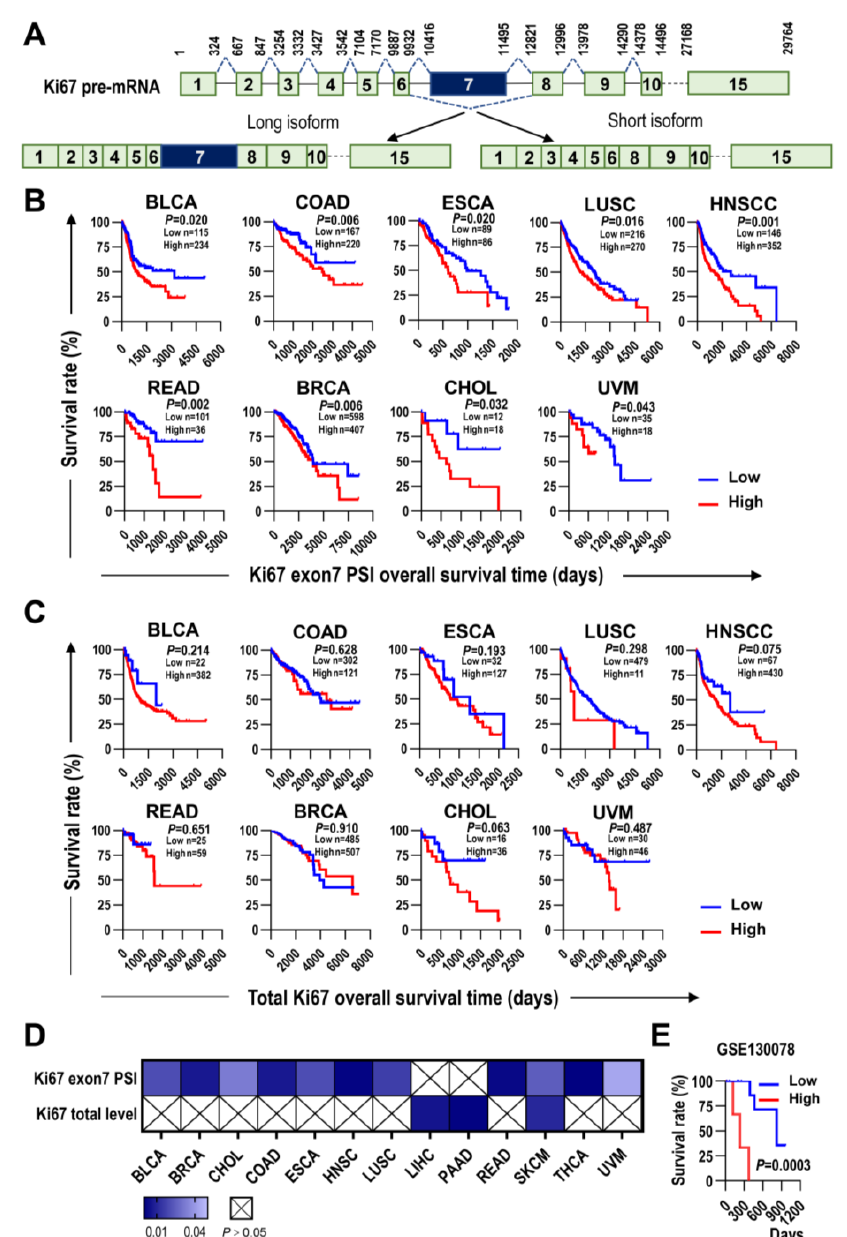
Figure 1. The inclusion level of Ki67 exon 7 is superior to Ki67 total transcription level in overall survival prediction of multiple types of cancer. ( A ) Schematic diagram of the alternative splicing of human Ki67 exon 7. Exon 7-included or -excluded transcripts encode long or short isoforms of Ki67, respectively. The boxes represent exons, and the lines represent introns in the pre-mRNA. The numbers above the exons and introns are the nucleotide positions in pre-mRNA. Dashed lines above or below introns indicate the RNA splicing direction. ( B , C ) Kaplan – Meier survival curves for overall survival (OS) based on the inclusion levels (PSI value) of Ki67 exon 7 ( B ) and the total Ki67 expression levels ( C ) in nine types of cancer (RNA-seq data, TCGA). ( D ) The heat map shows the summary of OS-related p -values of Ki67 exon 7 PSI and Ki67 total expression level in TCGA database. ( E ) Kaplan – Meier overall survival curves of re-analyzing Ki67 exon 7 alternative splicing in GSE130078 cohort. The p values were calculated using the log-rank test. BLCA — bladder urothelial cancer;